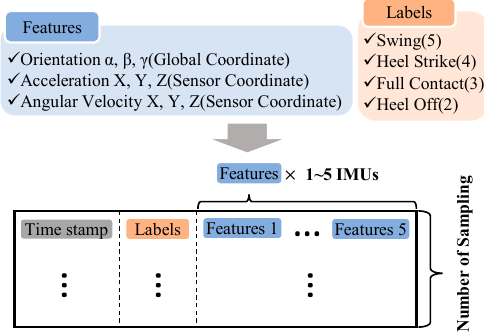
Figure 9. Low-level communication protocol: timestamp, labels, and inertial motion sensor data.